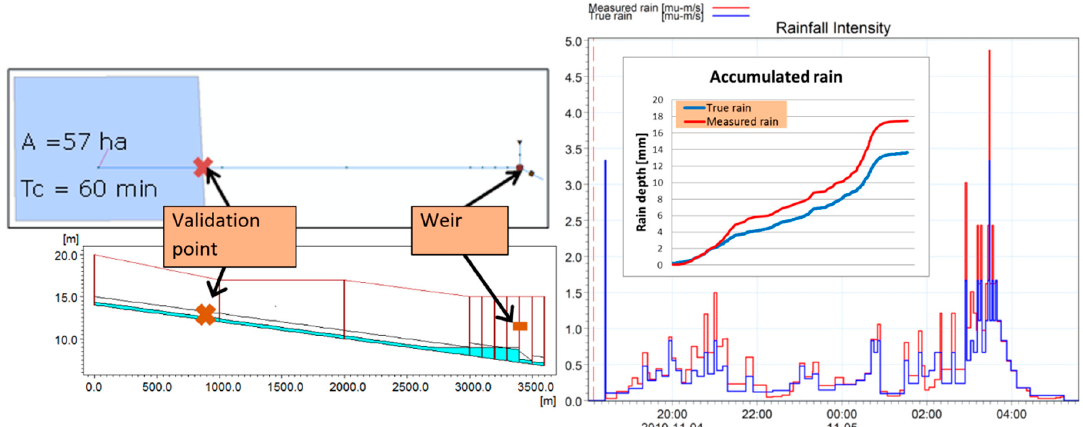
Figure 1. ( Left ) Plane view and longitudinal profile of the model setup. The longitudinal profile can be seen better in Figure 3. ( Right ) True and measured rainfall for the event analyzed.